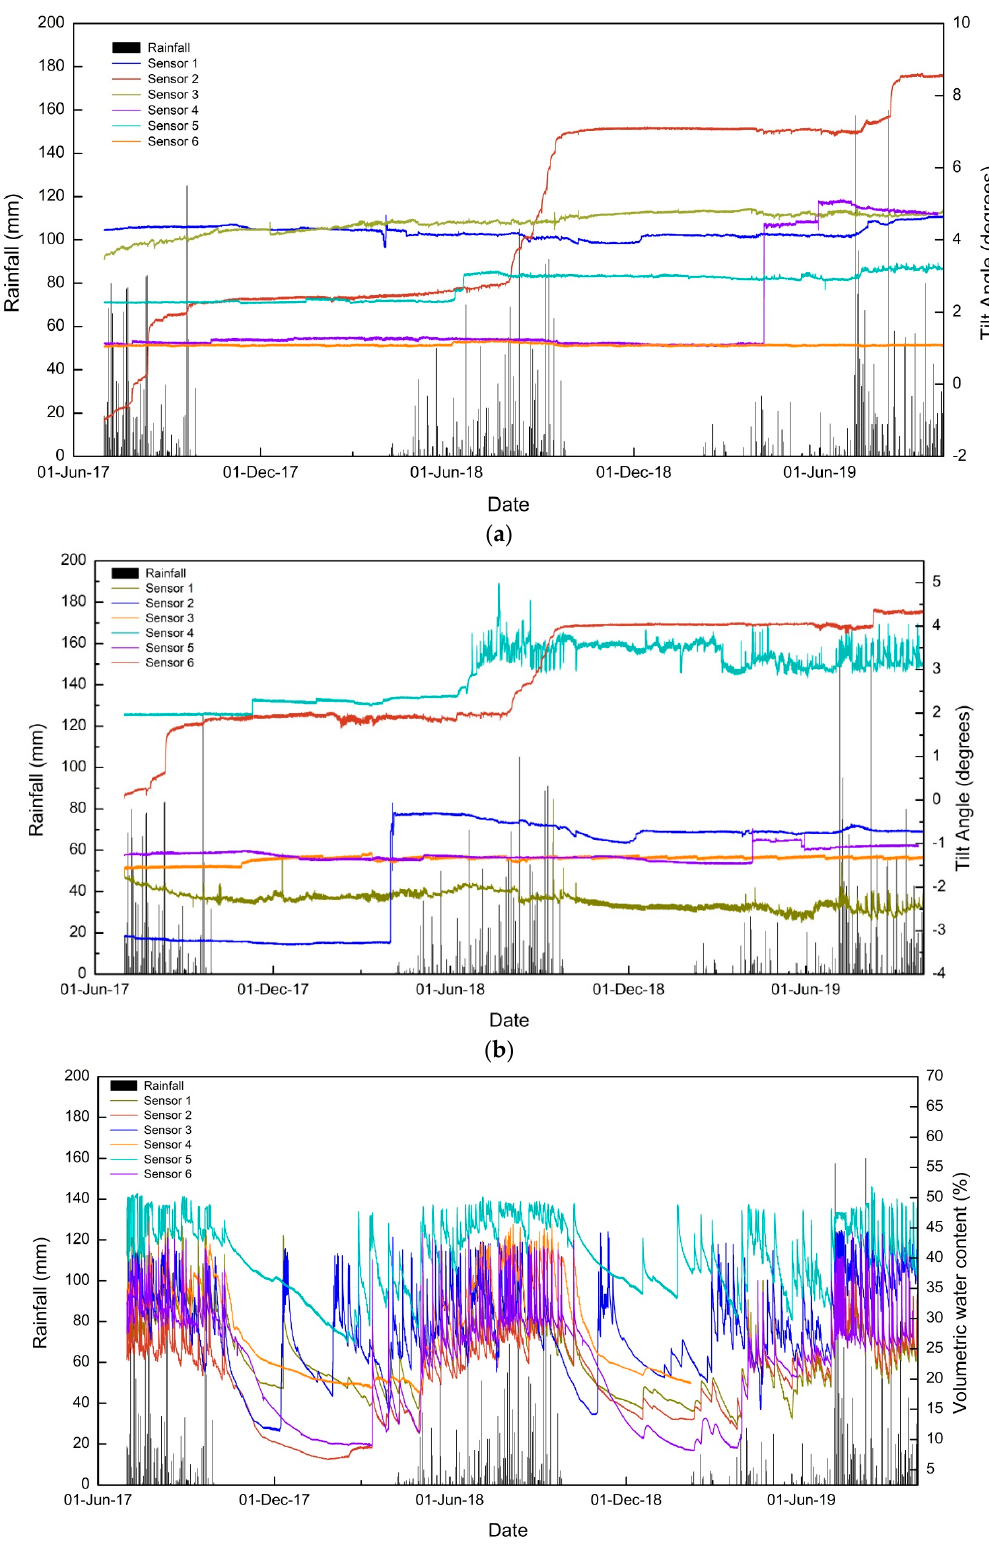
Figure 7. Data collected from six tilt sensors and volumetric water content sensors (2017–2019): ( a ) tilting angle in the direction parallel to the slope, ( b ) tilting angle in the direction perpendicular to the slope, and ( c ) volumetric moisture content.